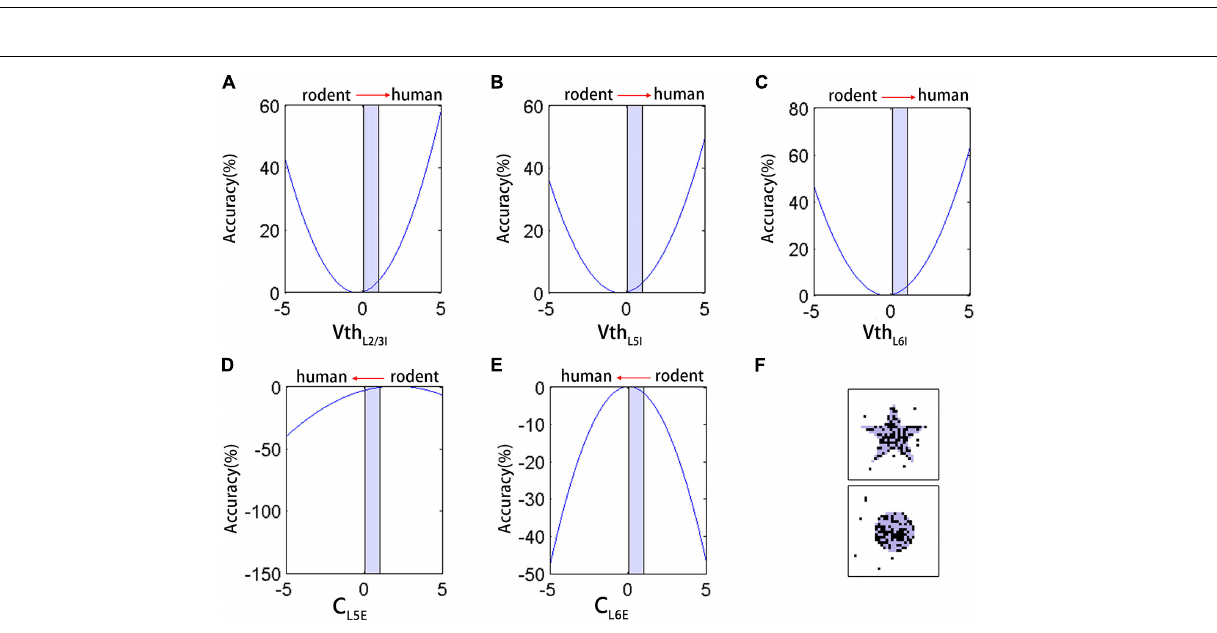
FIGURE 4 | Network signal transfer accuracy after adjusting different parameters individually. (A) The performance of rodent neural network after adjusting different parameters. (B) The performance of human neural network after adjusting different parameters. (C) The rodent neural network performance after adjusting background input. (D) The human neural network performance after adjusting background input. The error bars represent the standard error of the mean of nine independent experiments, P > 0.05 were considered not significant (ns); * P < 0.05, ** P < 0.01, *** P < 0.0001.